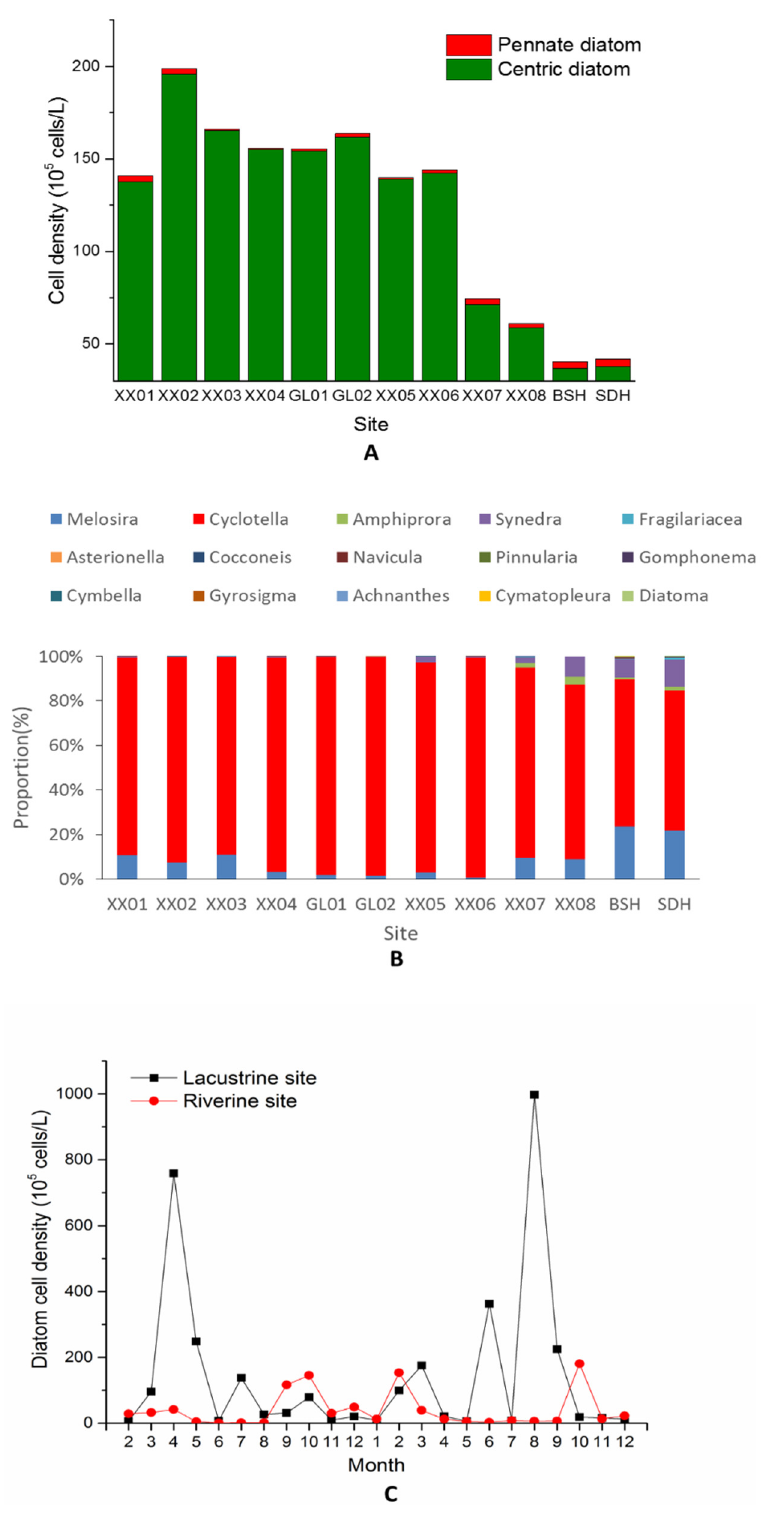
Figure 4. The diatom cell density ( A ) and proportion of pennate diatom cell density ( B ) at di ff erent sites. Monthly diatom cell density from February 2015 to December 2016 ( C